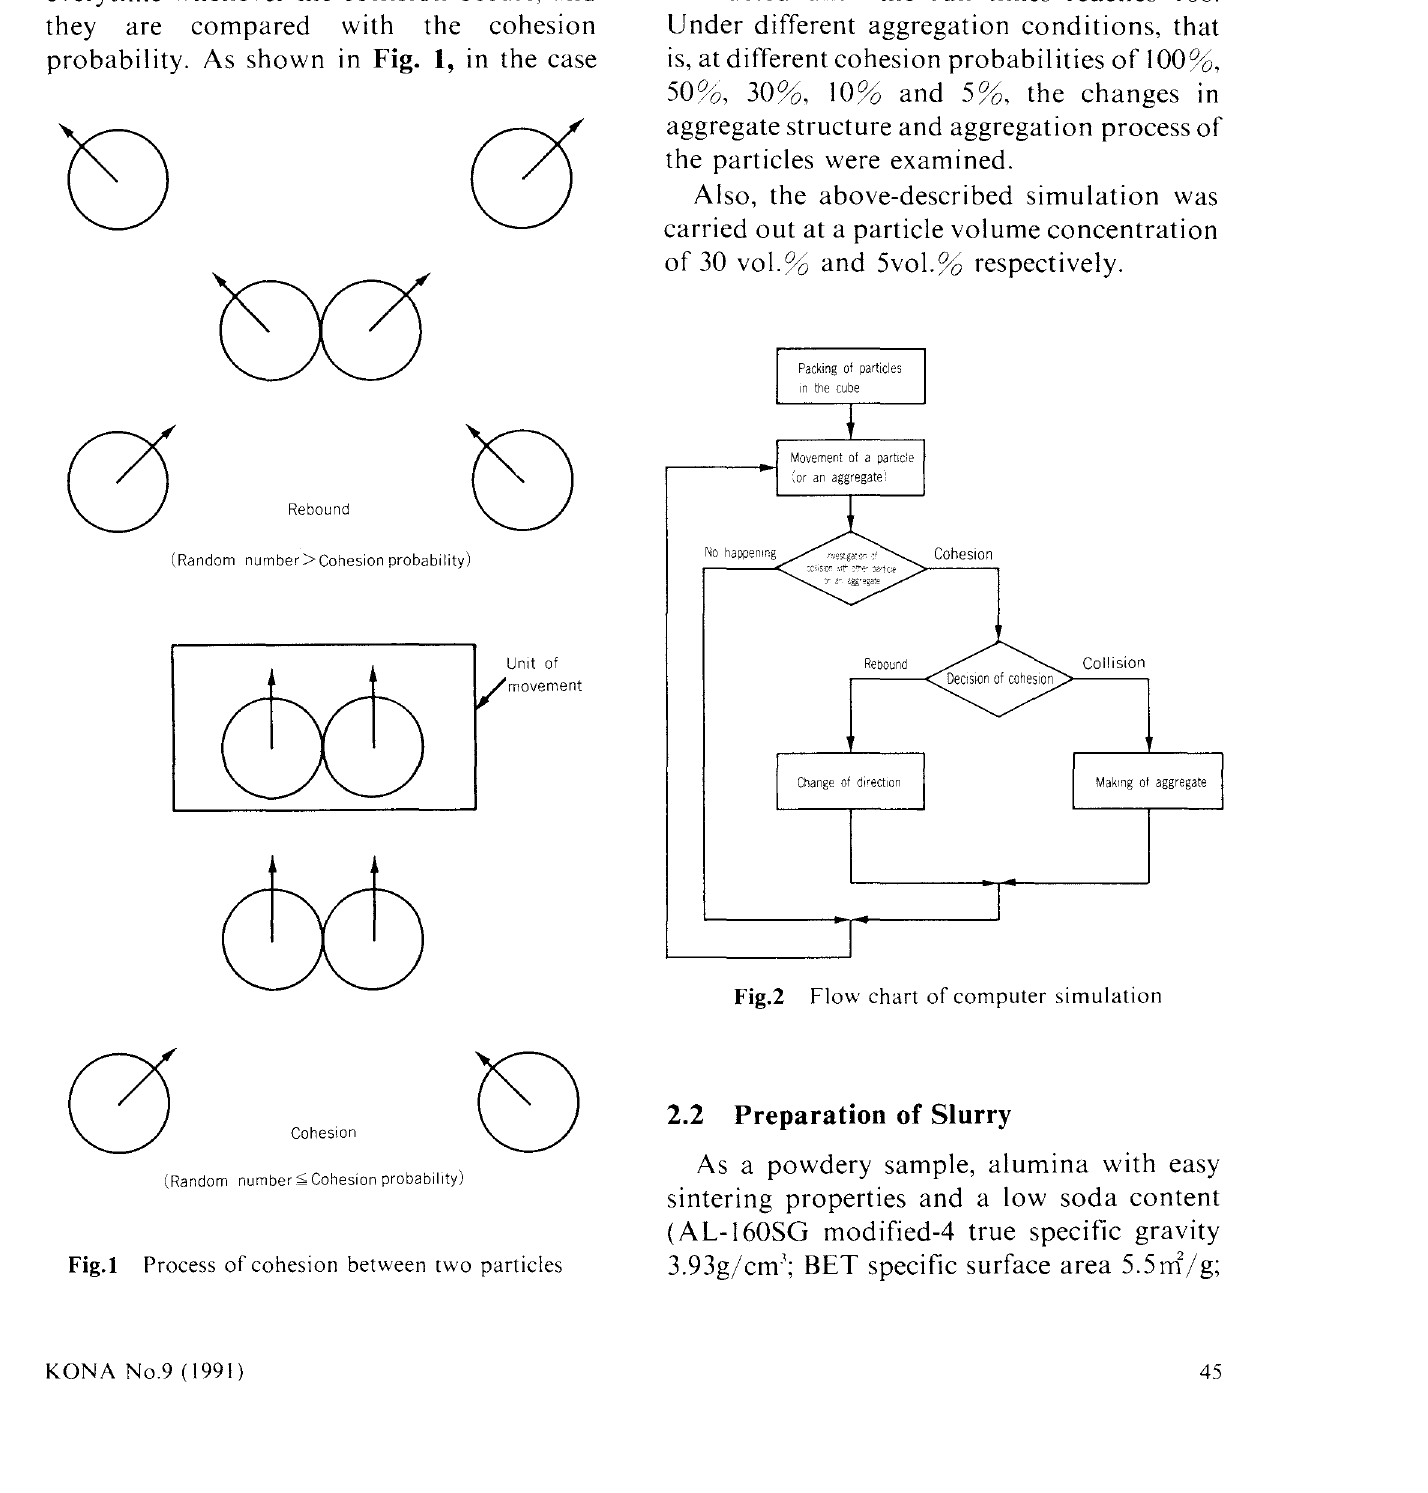
Fig.2 Flow chart of computer